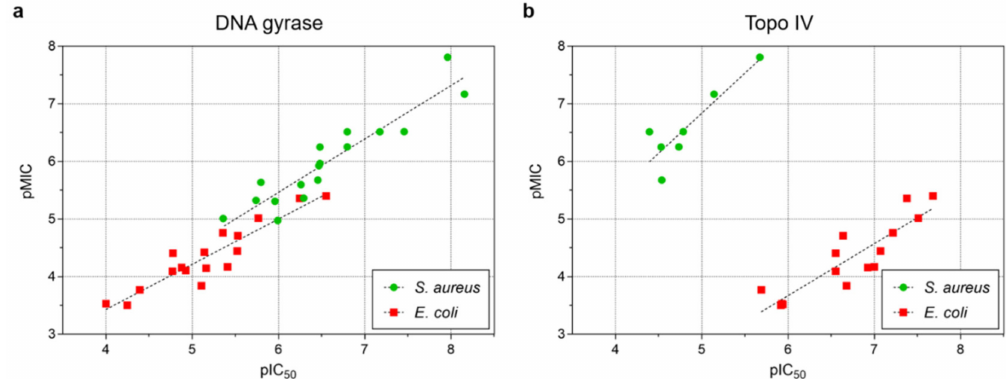
Figure 5. The correlation between antibacterial potency (pMIC = − logMIC in molar) of NBTIs and the corresponding S. aureus and E. coli inhibitory activity (pIC 50 = − logIC 50 in molar) of: ( a ) DNA gyrase and ( b ) Topo IV, respectively. A linear correlation may be observed for DNA gyrase of both bacterial strains ( R 2 = 0.864 and 0.856 for S. aureus and E. coli , respectively), while slightly inferior linear correlation can be obtained for Topo IV ( R 2 = 0.788 and 0.790 for E. coli and S. aureus